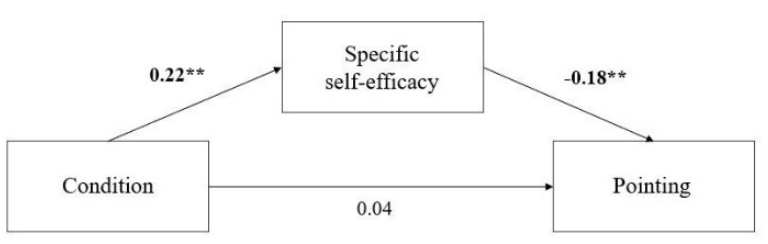
Figure 4. Mediation models of the effect of positive feedback on performance in pointing. ** p < 0.01.